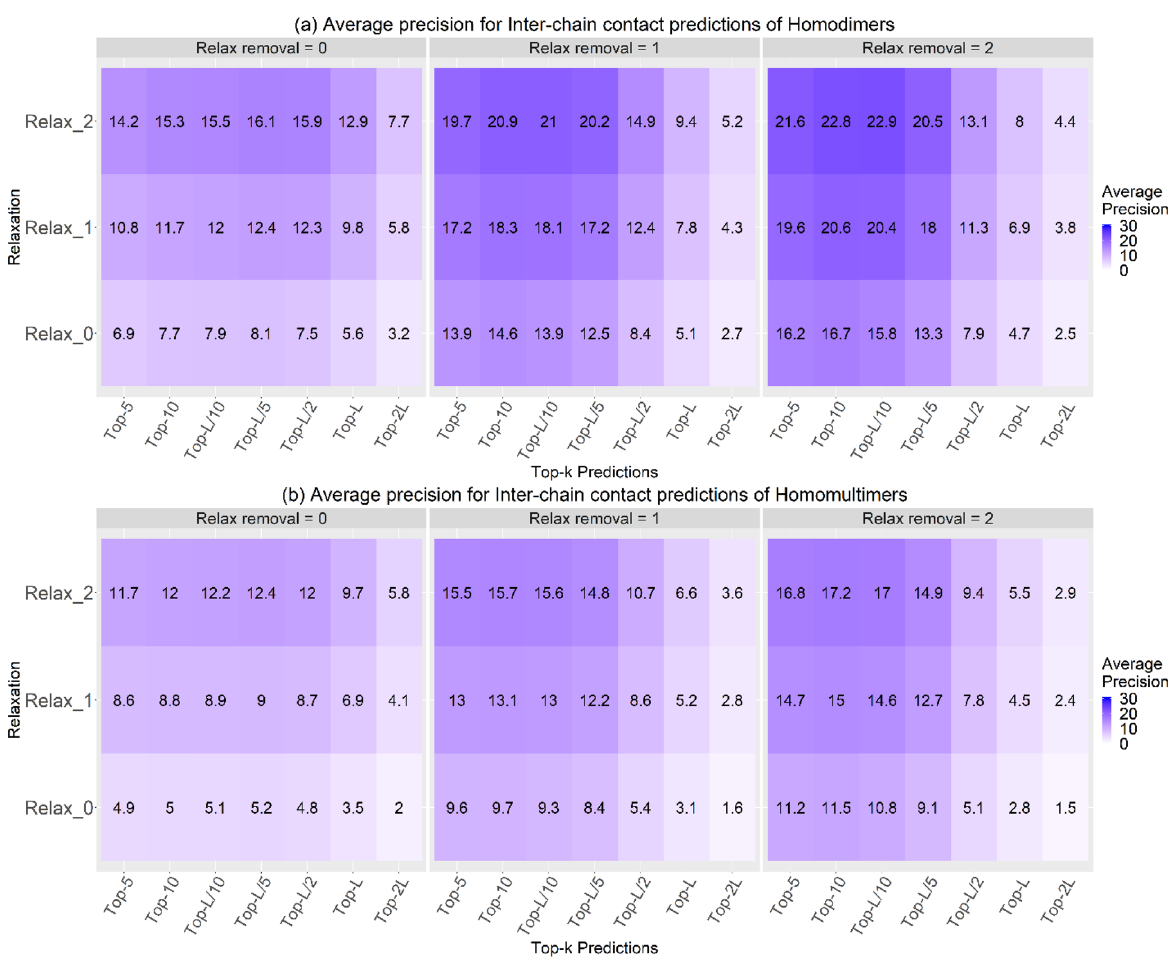
Figure 3. The precision heatmap of interchain contact predictions for the (a) homodimers and (b) homomultimers for the Top-k predictions where k = 5, 10, L/10, L/5, L/2, L, and 2L. For all categories, as we do more relax removal and relaxation, precision values increase within the respective Top-k categories. Relax removal = 2 and relaxation = 2 shows the best precision of 22.9% for homodimers and 17.0% for homomultimers within the Top-L/10